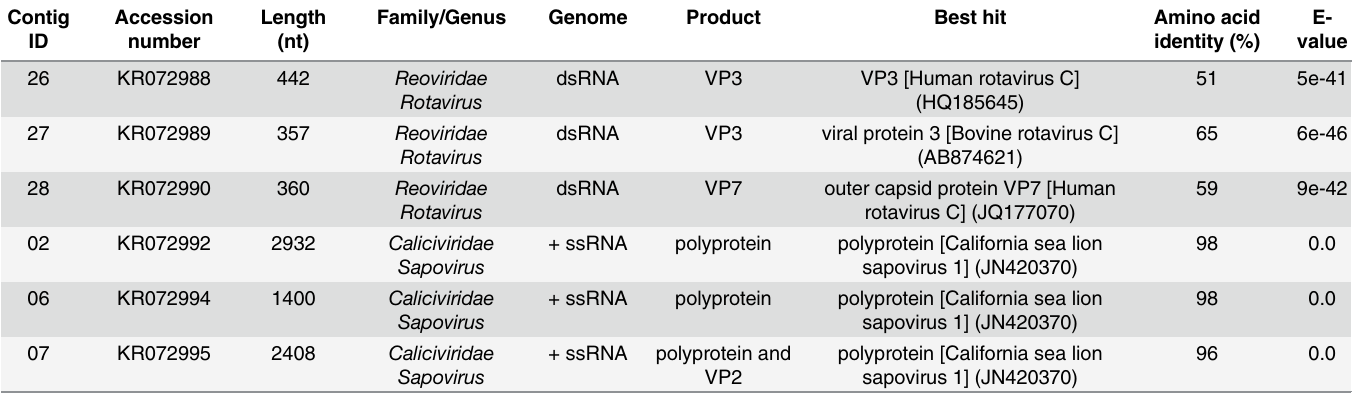
members, and one sequence shared 52% amino acid identity with HAV VP2. Phylogenetic analyses were based on the picornavirus polyprotein functional regions: P1, which encodes for structural proteins, and P2-P3, which encode for proteins involved in replication [28]. The analysis of partial P1 sequences identified here showed the fur seal picornavirus forming a monophyletic group with the Hepatovirus and Tremovirus genera, but on a different branch (Fig 5B). When partial sequences of P3 region were analyzed they still shared the same root, with the fur seal picornavirus placed in a similar way (Fig 5C). In addition to the above-mentioned picornaviruses, distinct members of this family were found only in Subantarctic fur seals. With the exception of one sequence whose best BLASTx hit had 52% of amino acid identity to a kobuvirus, all other contigs displayed the highest amino acid identity to Feline sakobuvirus A (FSVA), which ranged from 58 – 73% with a total coverage of 59% of its polyprotein (Fig 6A). One sequence displayed 59% of amino acid iden- tity to FSVA VP1, and the amino acid identity of VP3 was of 66%. The sequence covering the 2C region had 59% of amino acid identity, while the two 3D sequences here identified ranged from 65 – 73% of FSVA 3D region. Phylogenetic analyses of partial P2 and P3 regions (Fig 6B and 6C, respectively) showed the fur seal picornavirus, temporarily named Fur seal sakobu- virus (FSSV), clustered with FSVA, member of the Sakobuvirus genus.